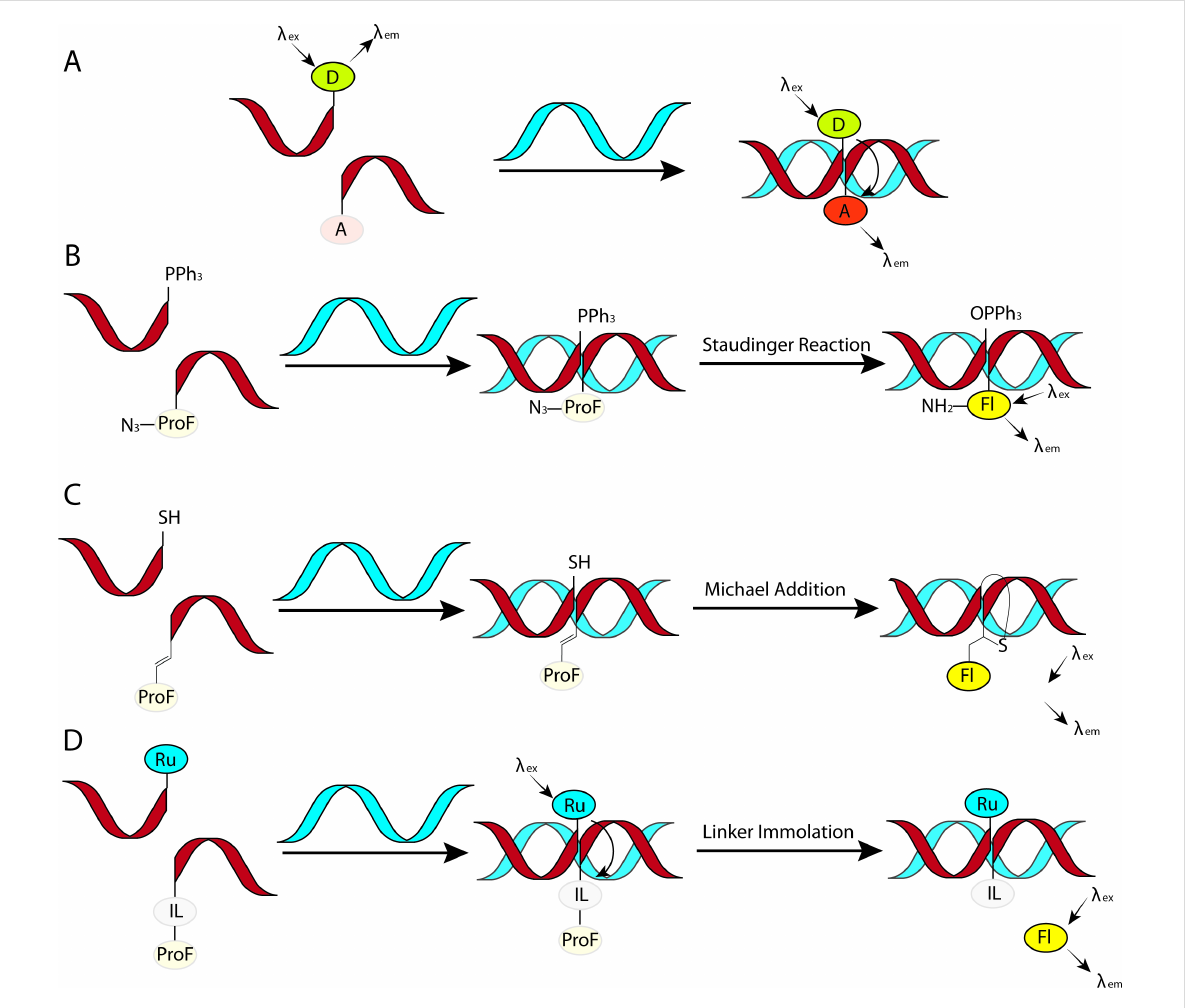
Figure 25: Templated fluorogenic detection of oligonucleotides using two PNAs. (A) Templated FRET depends on hybridization of PNAs to adjacent positions on the target sequence to bring the donor and acceptor in proximity. Templated reactions such as (B) Staudinger reaction or (C) conjugate addition of thiols can be used to turn on fluorescence of a caged pro-fluorophore. (D) Photochemical templated reactions target an immolative linker which both tethers and quenches a pro-fluorescent